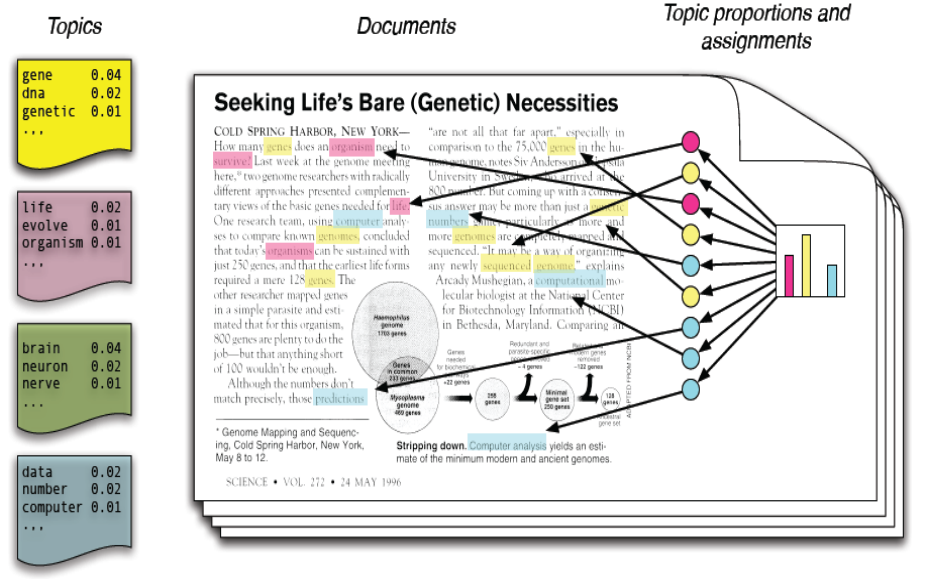
Figure A1. Source: David M. Blei. “Probabilistic topic models”. Communications of the ACM